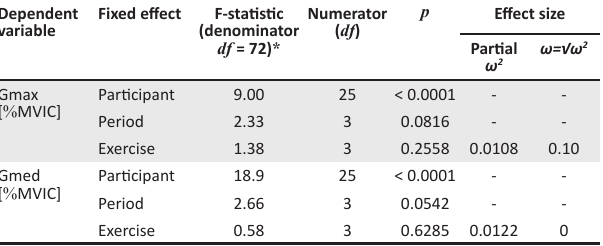
TABLE 3 : Three-way analysis of variance (ANOVA) of gluteus maximus (Gmax) and gluteus medius (Gmed).